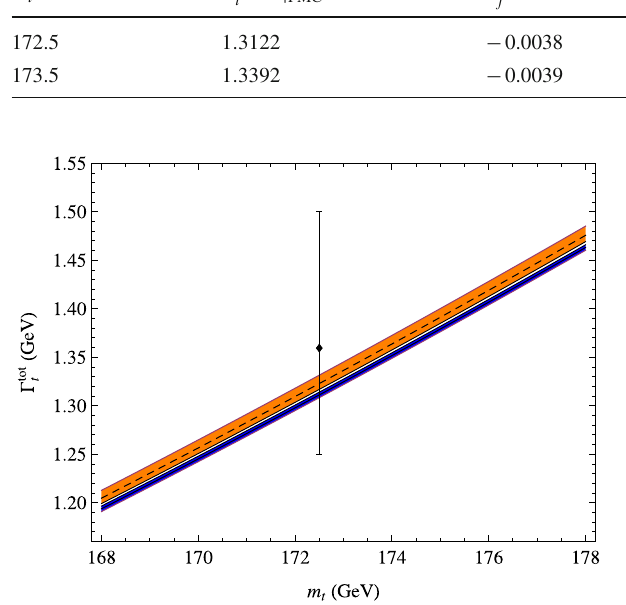
and the NLO electroweak corrections δ NLO f